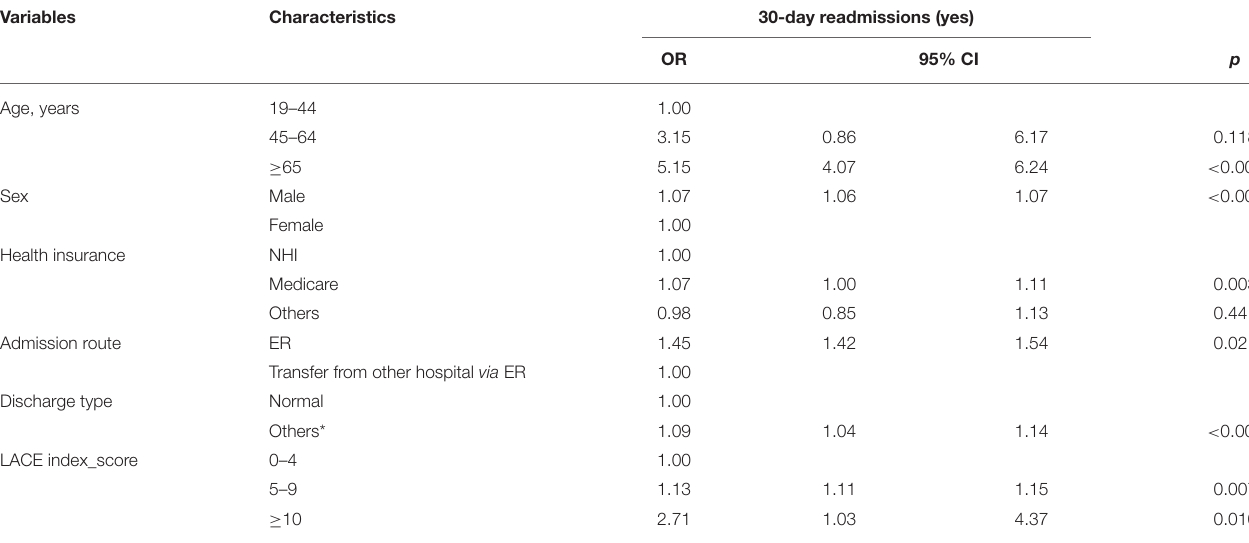
TABLE 2 | Multivariate logistic regression analysis for 30-day readmission in patients hospitalized with AMI ( N = 205).